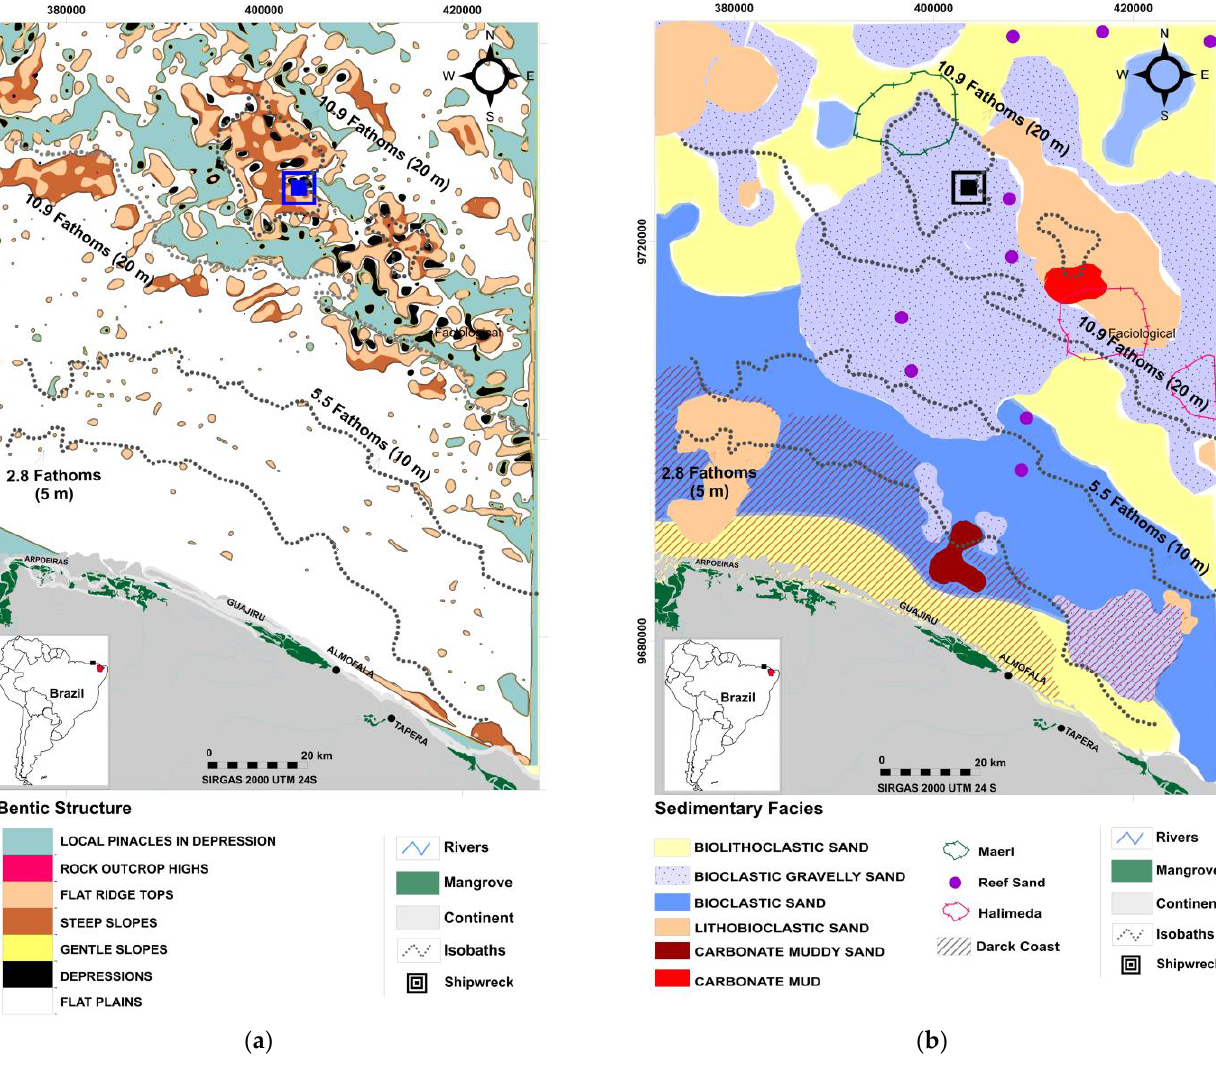
Figure 5. ( a ) Benthic Structure map; ( b ) Sedimentary Facies map. Source: Figure 5b elaborated from integration of different data [35,37,40,46,50,51 – 56]. The rock outcrops called “stones” and “old man’s nail” in Almofala coincide with the flat ridge top found in the benthic structure map (Figure 5a). The sedimentation of the